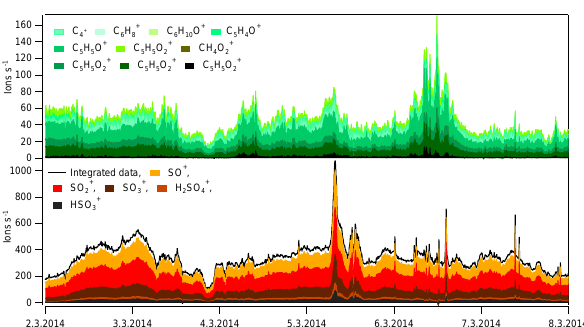
Figure 9. Concentrations of main sulfate ions (SO + , SO + ) from peak fitting and sulfate calculated from HSO + and H 2 SO + 3 4 application of the fragmentation table with integrated data (lower panel) and time series of the isobaric organic ions in the same m/Q as sulfate fragments (upper